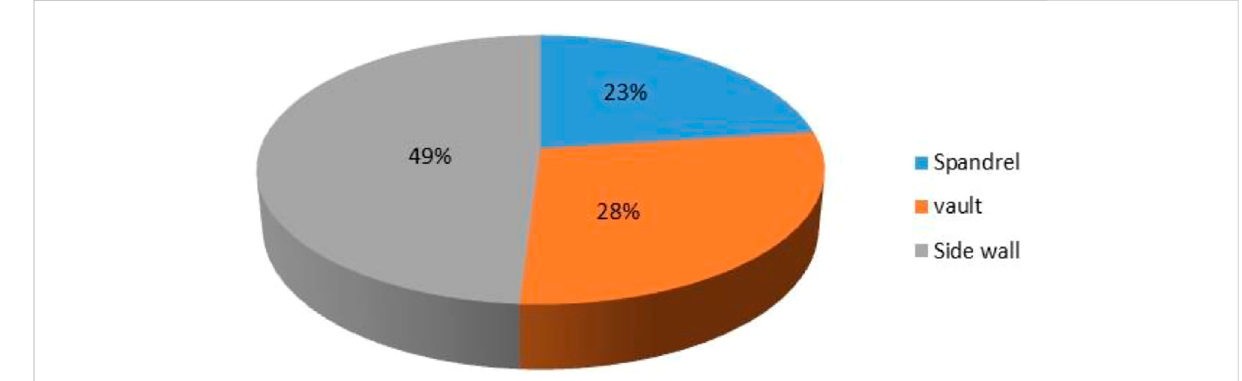
FIGURE 1 Statistical diagram of main distribution positions of lining cracks.